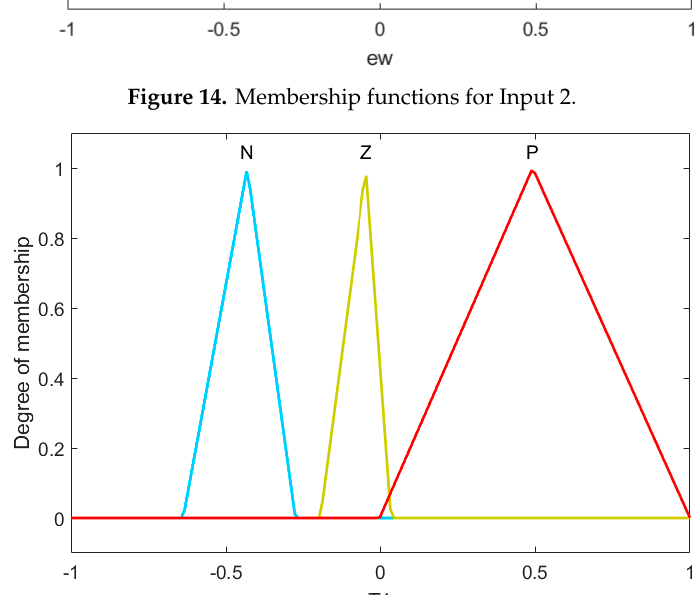
Figure 15. Membership functions for Output 1.